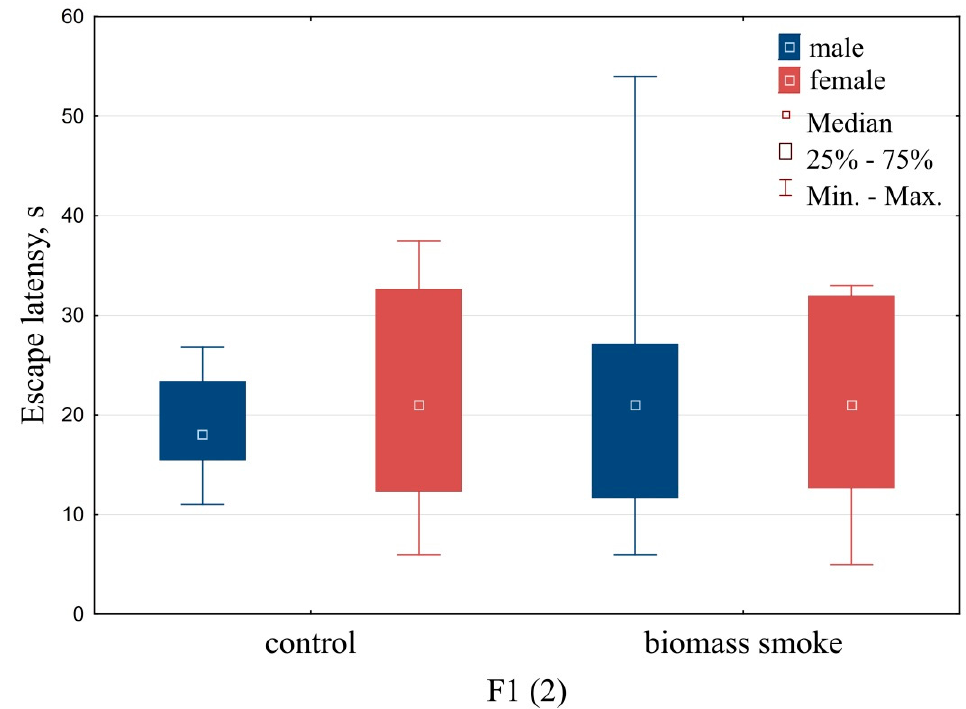
Figure 5. Test results in the Morris water maze. Offspring born by mating in the long-term period after exposure.